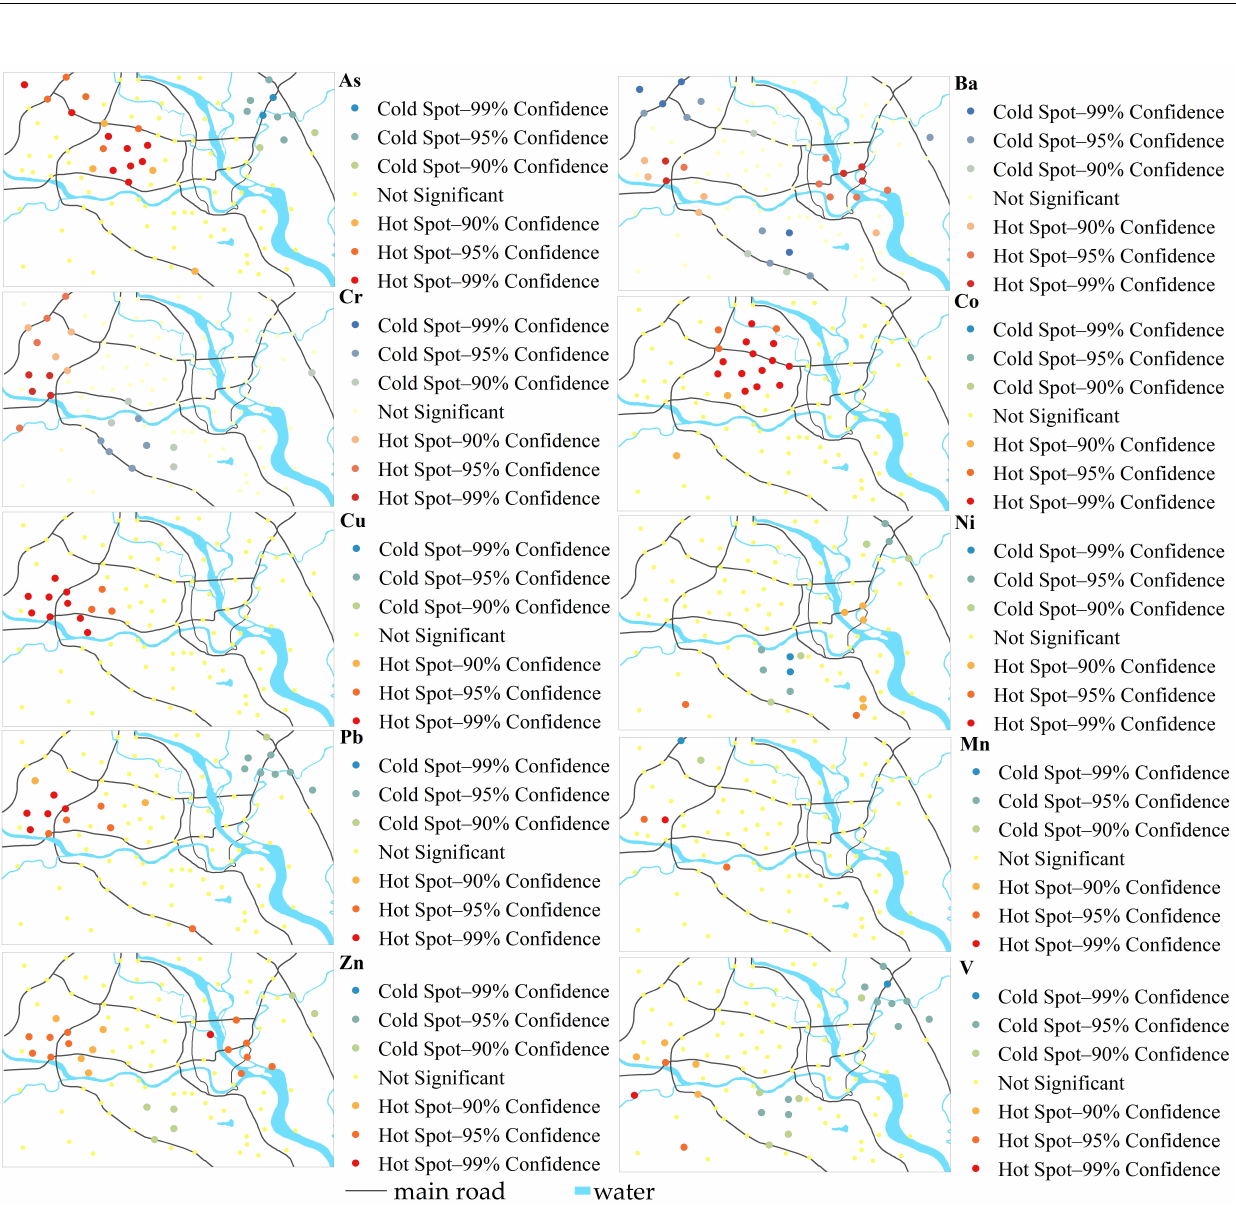
Figure 2. The hot spots of HMs in Mianyang urban area. Figure 2 shows that the hot spots of As were mainly in the science and technology industrial zone and the educational and residential zone; the hot spots of Ba were mainly concentrated in the high-tech industrial area and the eastern industrial zone; the hot spots of Co were primarily distributed in the educational and residential area; the hot spots of Cr were mainly concentrated in the science and technology industrial zone and the high-tech industrial area; the hot spots of Cu and Mn were mainly concentrated in the high-tech industrial zone; the Ni hot spots were distributed in the eastern industrial zone and the southern suburban area; the Pb hot spots were located in the high-tech industrial area and the educational and residential area; the Zn hot spots were primarily located in the high-tech industrial zone and the eastern industrial zone; and the V hot spots were located in the high-tech industrial zone and the southern suburban zone. Overall, all of the 10 HMs have different spatial aggregation levels, of which Ba, As, Cu, Pb, Co, Cr, and Zn show obvious enrichment trends, but different HMs have different spatial aggregation regions, which may be related to the different sources of